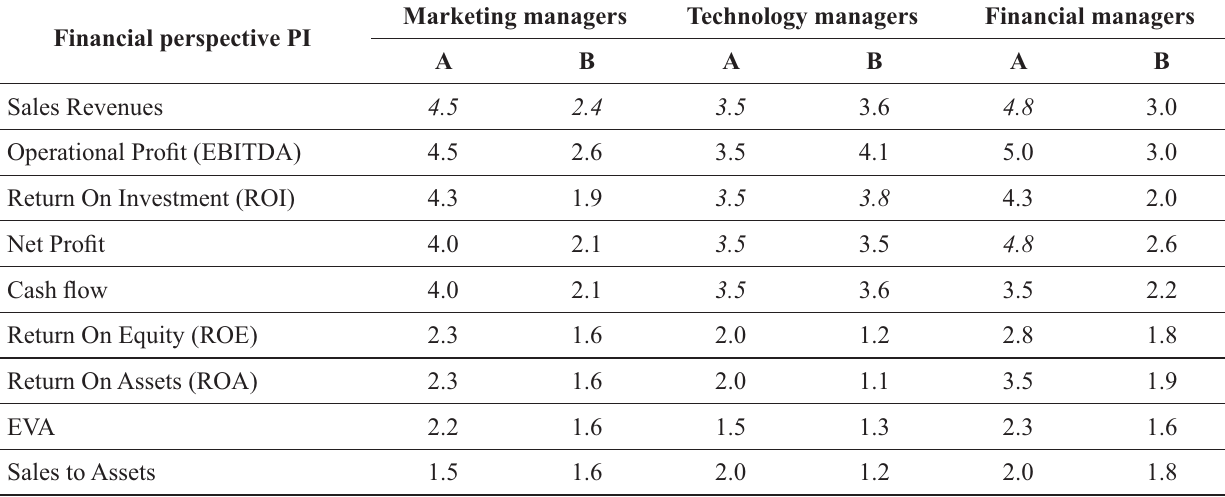
Table 2. Financial PI usage by managers of companies A and B